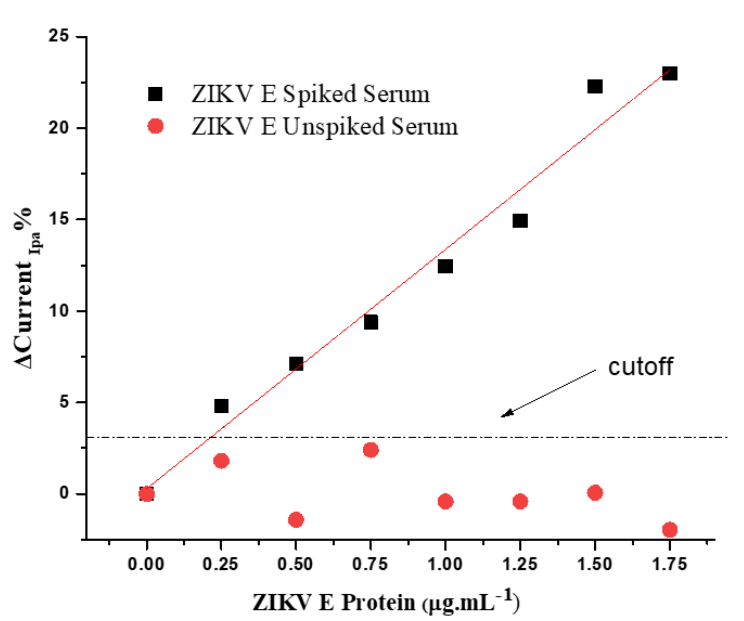
Figure 7. Analytical curve of the CV anodic peaks for immunosensor response to the serum pool spiked with ZIKV E protein diluted in PBS 100 mmol · L − 1 (pH 7.4) and the unspiked serum pool diluted under the same conditions. Measurements were performed in the presence of KCl (100 mmol · L − 1 ) for a 0.05 V · s − 1 scan rate.